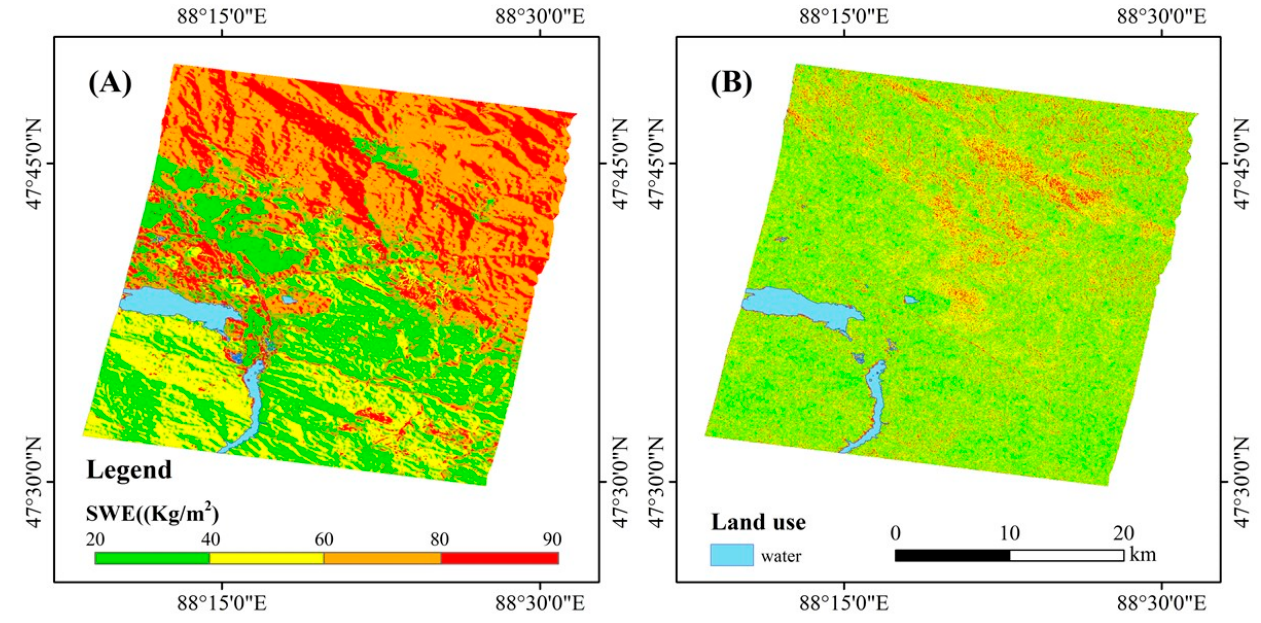
Figure 7. Optimized model ( A ) and original model ( B ) snow water equivalent inversion results. After the optimization of the model, the overall snow weight in the study area is distributed between 23.7 mm and 87.6 mm, with an average of 48.7 mm. The SWE of the optimized model clearly shows an increasing trend along with the increase in latitude, which is consistent with the trend of the terrain increasing from south to north in the study area (Figure 5A). Among different land types, the SWE of bare land and cultivated land on the sunny slope is the lowest, and the main SWE distribution is 20–40 mm. The SWE obtained from the inversion is relatively high, mainly distributed at 60–90 mm in the grassland with a higher altitude and northern latitude. The performance of the SWE is also different under different constraints of the same underlying surface, which is mainly reflected in the fact that the SWE in shady slope areas is generally higher than in sunny slope areas. This may be because sunshine, wind, and other conditions affect the accumulation of snow on the sunny slope, making the SWE value on the shady slope higher. At the same time, compared with the results of the model without optimization, the estimation of the SWE between different land types is clearer (Figure 7). The optimized model can clearly distinguish that the snowfall value of the cultivated land in the northern part of the study area is low, but not mixed with the northern grassland. It can be seen that the SWE distribution without optimization is mainly concentrated at 20–60 mm. At the same time, the difference in the SWE between different land types decreases and is difficult to distinguish. This is mainly because the model is not optimized and the fitting degree between the ratio of the snow thermal resistance and the backscattering coefficient is insufficient, which leads to great errors in the simulation of the overall snow thermal resistance value. On the whole, the optimized model can better realize SWE inversion in the study